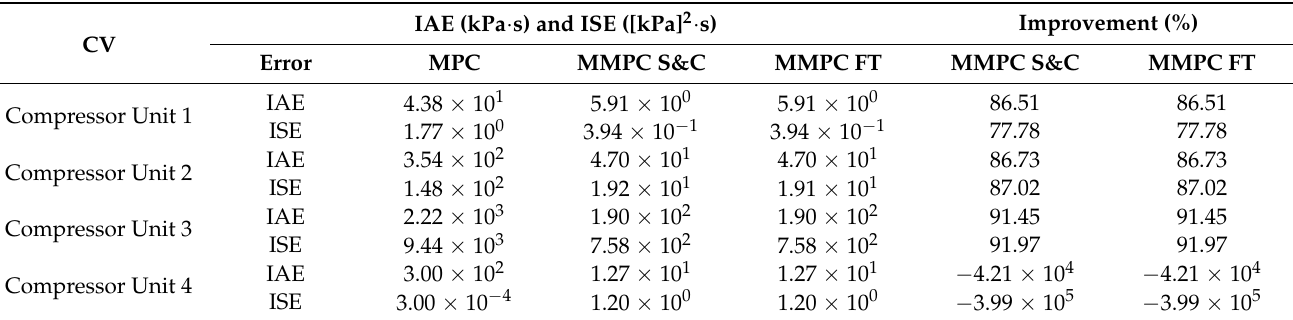
Table 13. Comparison of IAE and ISE on the compressor unit with changes on compressor unit 3 (MIMO Model